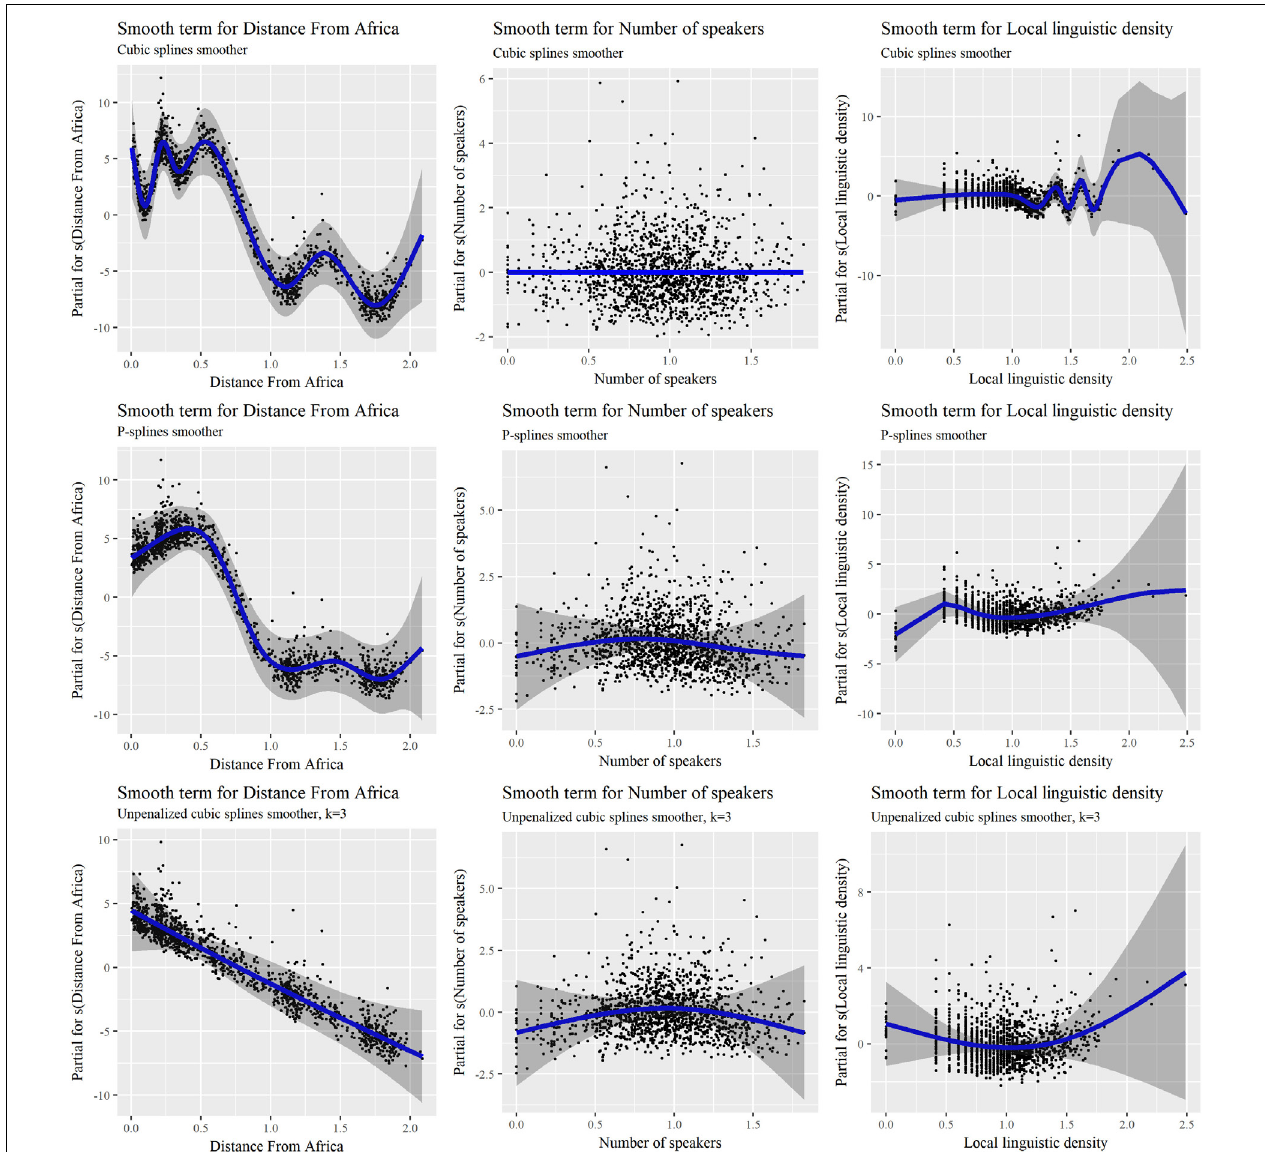
FIGURE 4 | Smooth terms for Distance from Africa , Number of Speakers, and Local linguistic density , for three smoothing approaches in an inverse-Gaussian GAMM: cubic splines (top), P-splines (middle), and cubic splines with a fixed smoothing parameter equal to